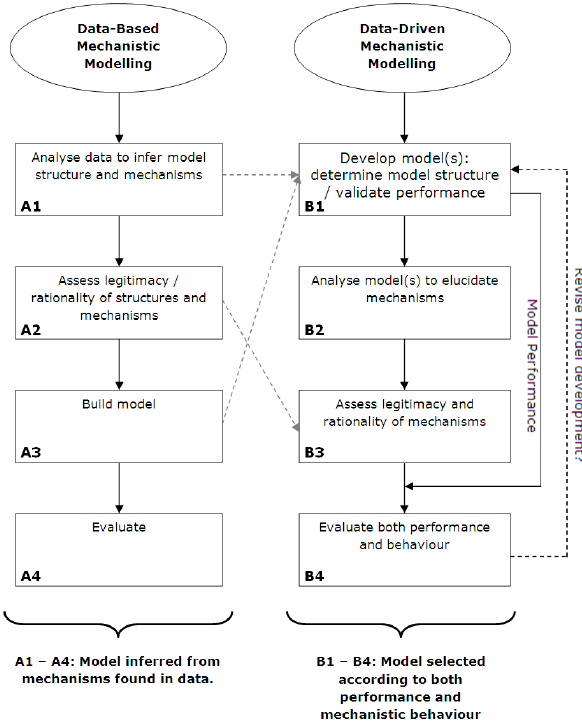
Fig. 2. Reordering of the DBM framework to generate the DDMMF. Grey dashed lines indicate where conceptual steps contained within the DBM approach are incorporated into the DDMMF approach.